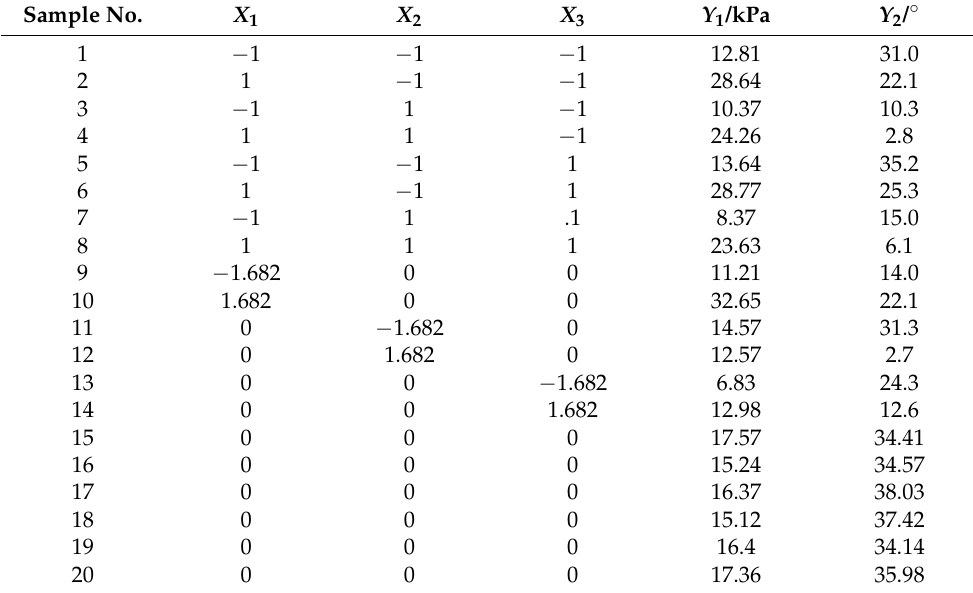
Table 3. Experiment scheme and test results. Sample